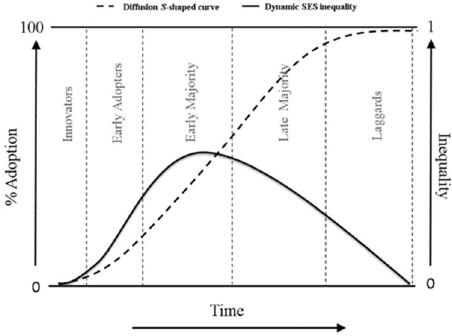
Fig. 2 Hypothetical relationship between technology diffusion and health inequalities. Retrieved from (Zapata-Moya et al.,